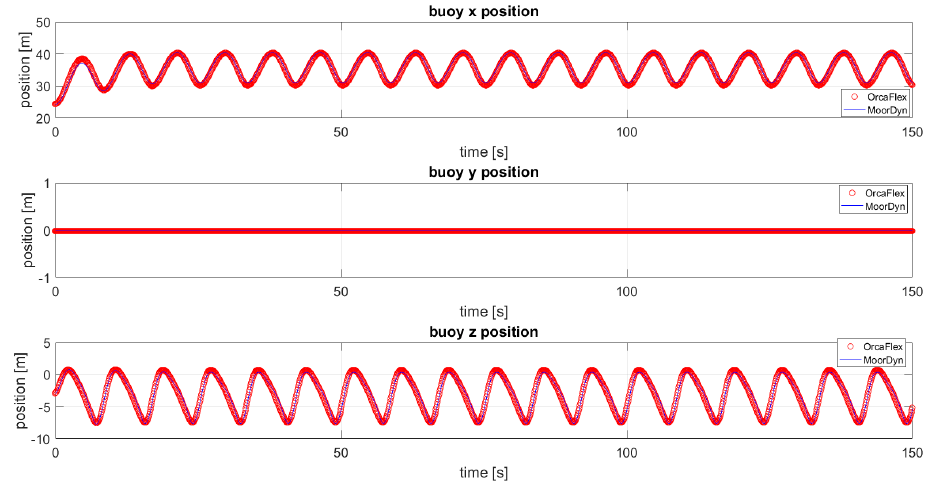
J. Mar. Sci. Eng. 2019 , 7 , x; doi: FOR PEER REVIEW Figure 8. Simulation case 2: Time series of buoy’s position. Figure 8. Simulation case 2: Time series of buoy’s position.